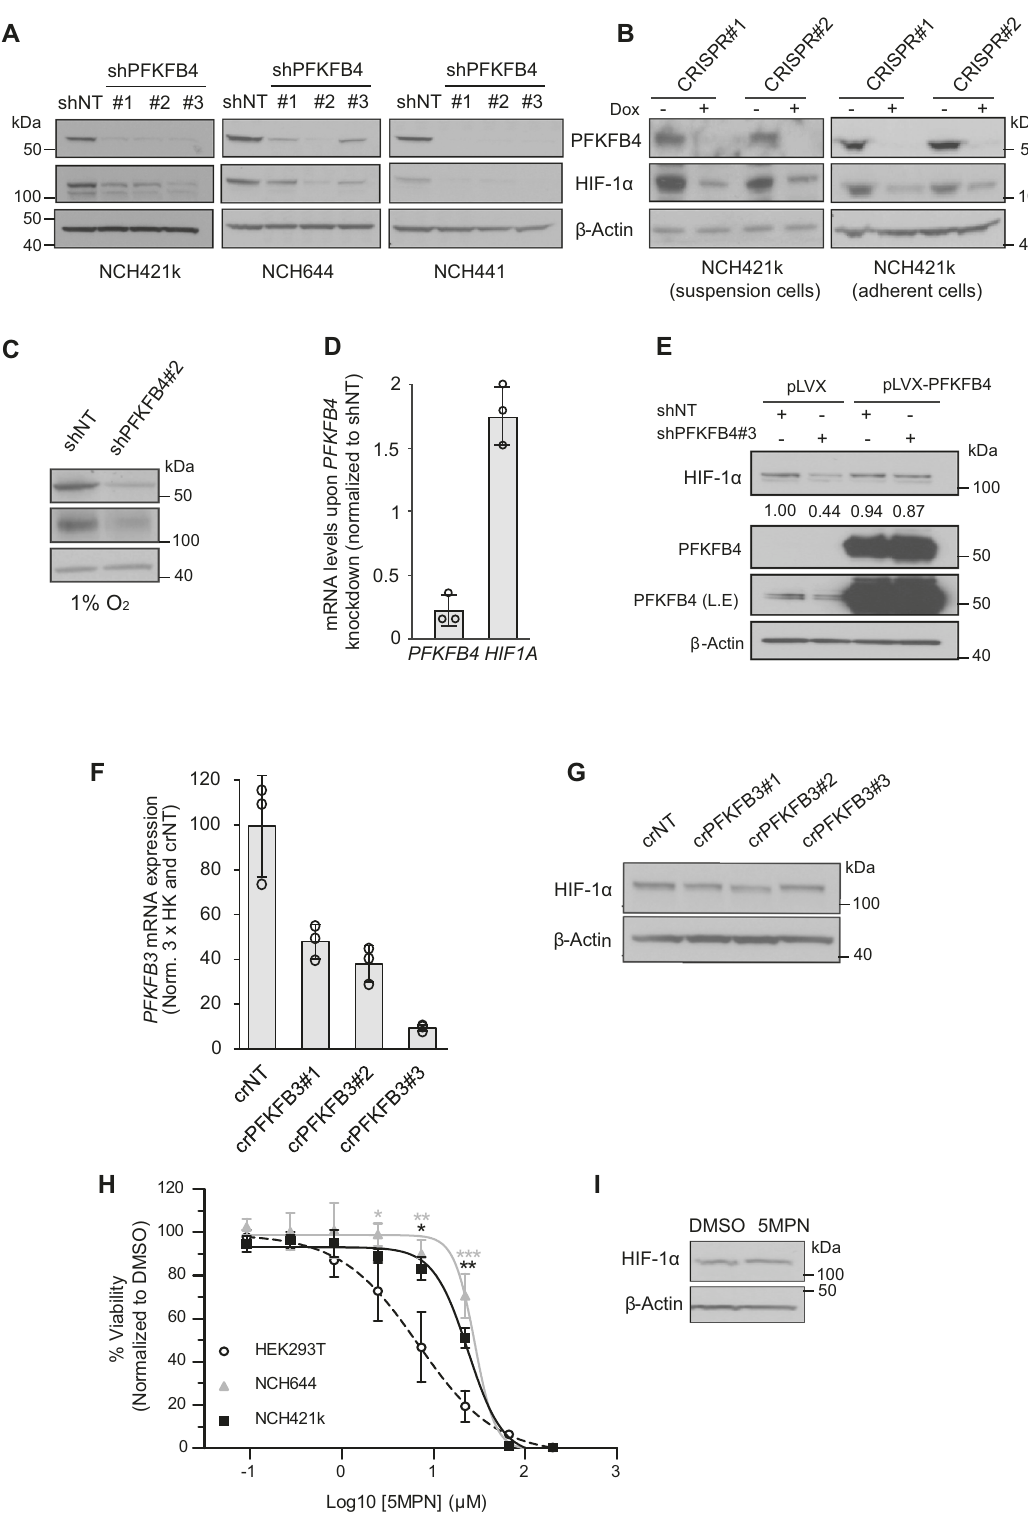
was not the case in cells expressing mutant HIF-1 α (Fig.